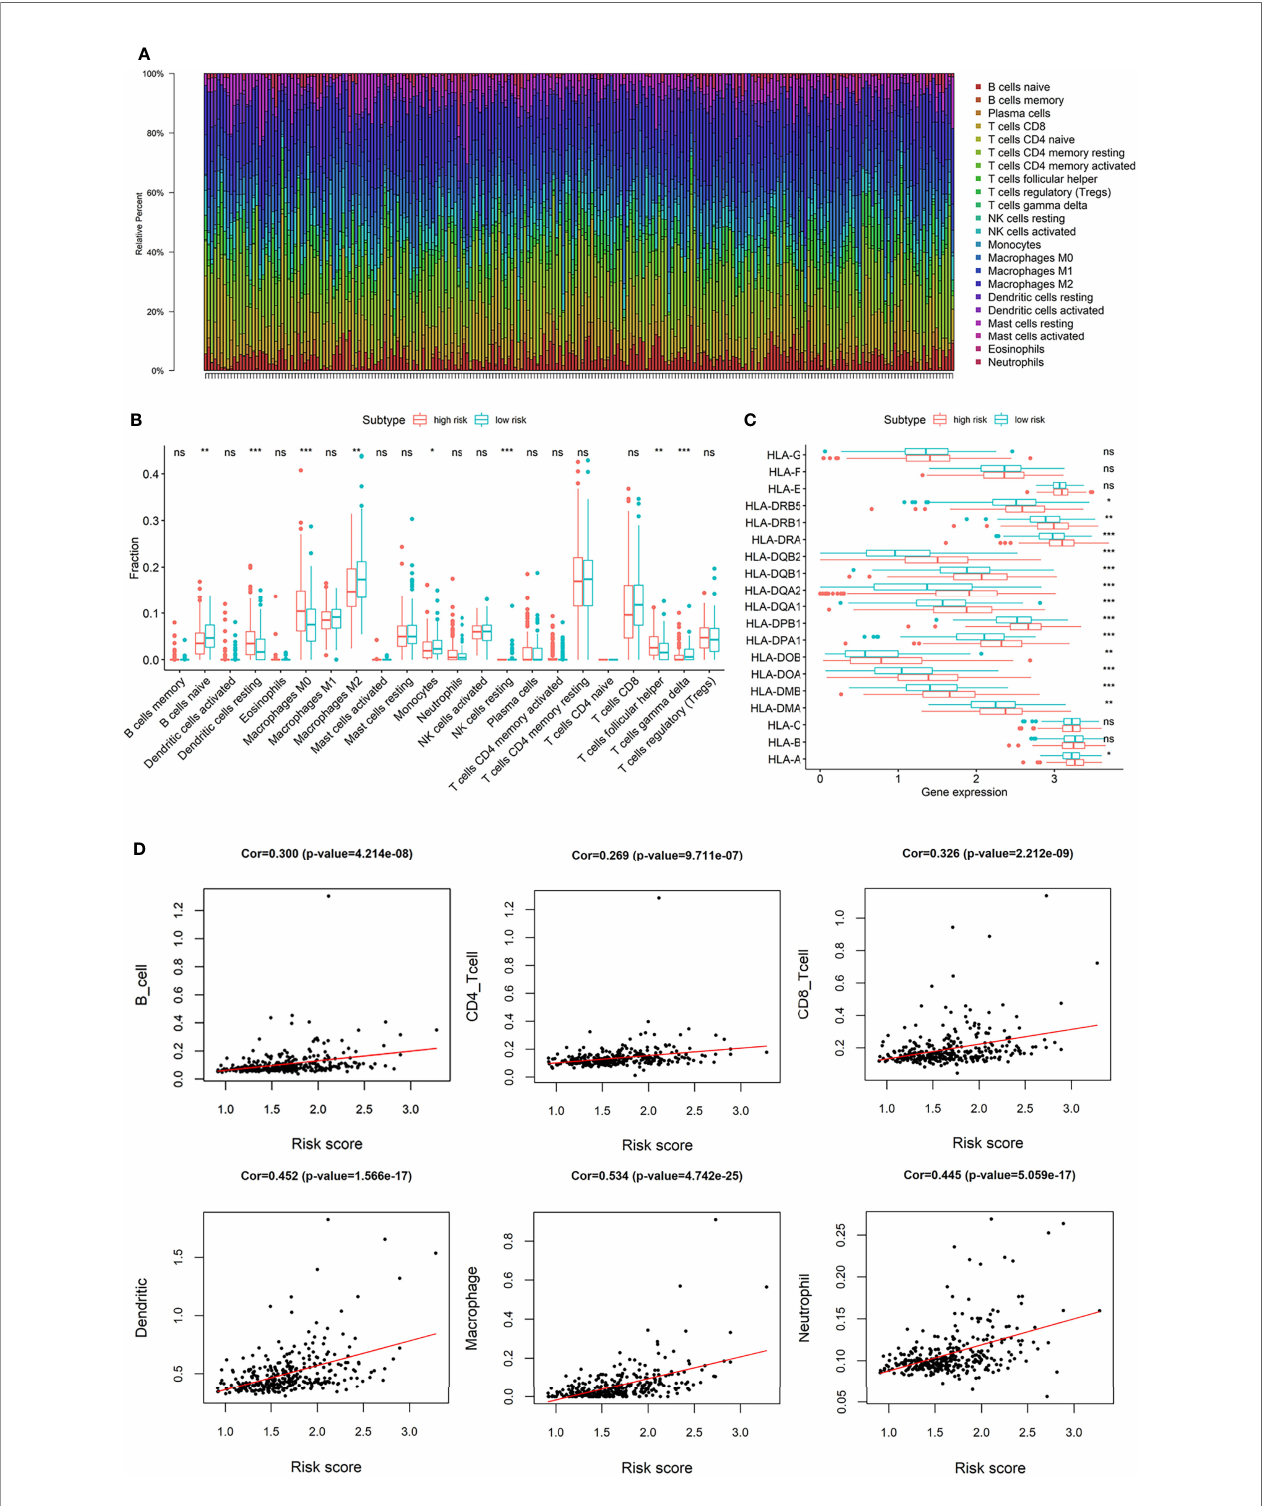
FIGURE 7 | (A) The composition of immune in fi ltrating cells in TCGA-LIHC patients; (B) Differences of immune in fi ltration cells between high and low risk group; (C) Differences of HLA-related genes between high and low risk group; (D) The correlation between risk score and the abundances of B cells, CD4+ T cells, CD8+ T cells, macrophages, neutrophils, and dendritic cells. (*p < 0.05; **p < 0.01; ***p < 0.001; “ ns ” means “ no signi fi cant difference ”